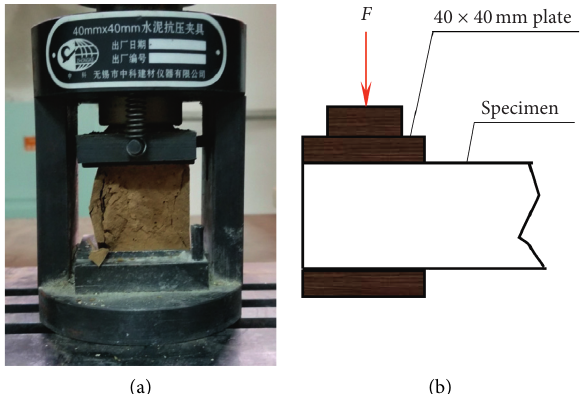
Figure 4: The compressive test: (a) the figure of front view; (b) the schematic diagram from side